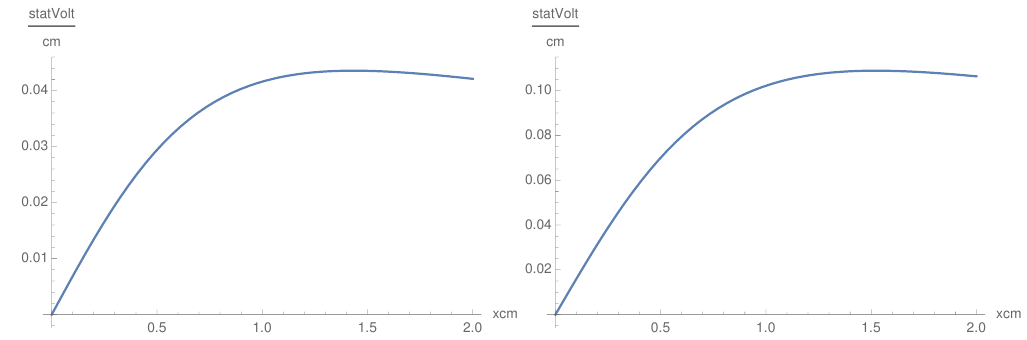
Figure 4. E y as a function of x for z = 1 cm for ω = 1 GHz ( left ) and ω = 2 GHz ( right ).